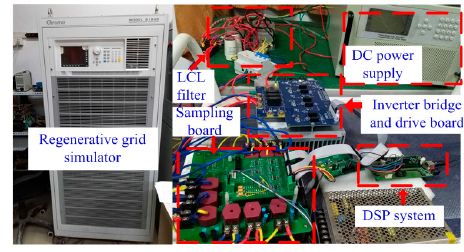
Figure 14. Output currents of the conventional inverter for different SCRs. ( a ) L g = 20.4 μ H (SCR = 45). ( b ) L g = 61 μ H (SCR = 15). ( c ) L g = 184 μ mH (SCR = 5). ( d ) L g steps to 400 μ H from 20.4 μ H.